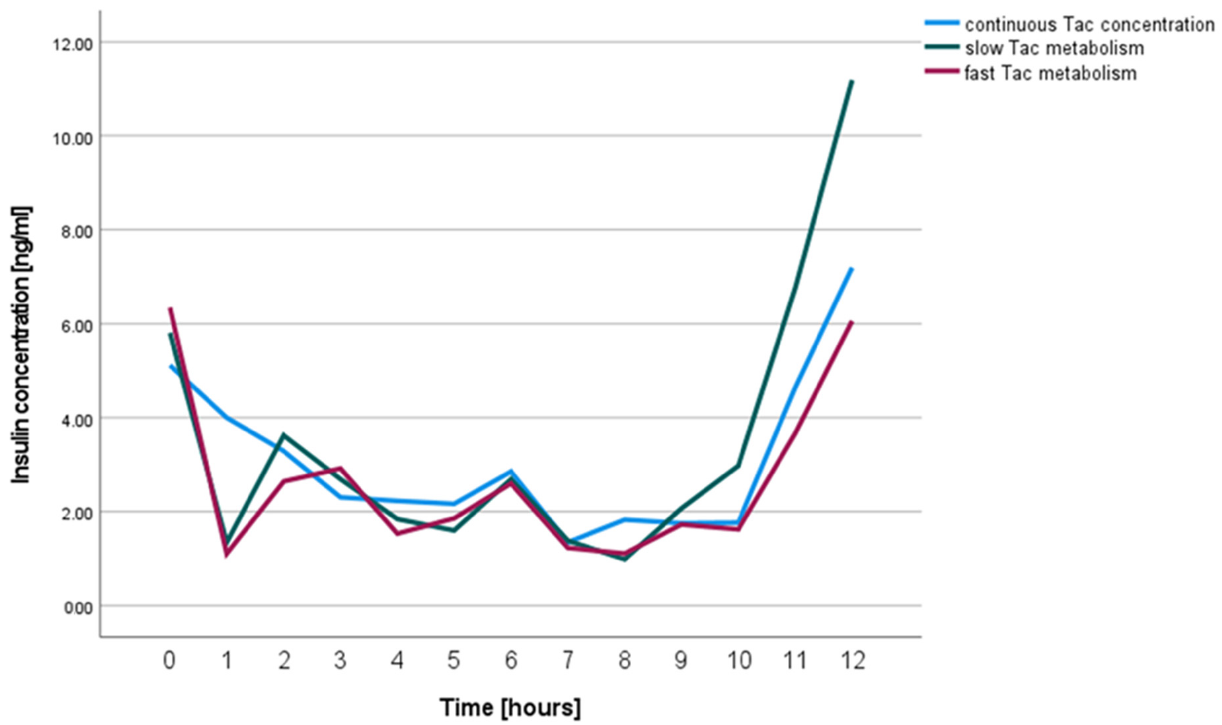
Figure 2. Insulin concentrations in cell culture medium supernatants of INS-1 cells treated with continuous Tac concentrations (blue), and variable concentrations modeling Tac kinetics of slow (green) and fast metabolizers (red).